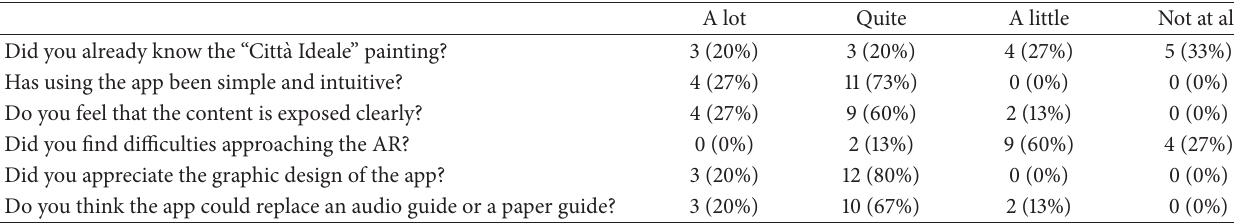
Table 3: Users’ answers related to the “Citt`a Ideale”